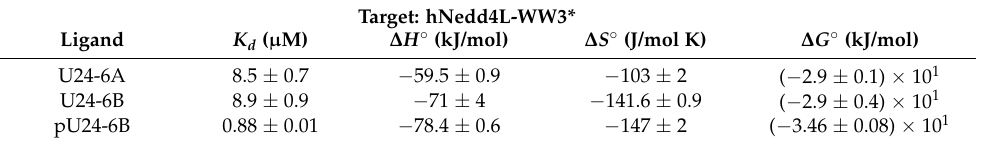
Figure 1. ITC data for ( a ) U24-6A peptide, ( b ) U24-6B peptide, and ( c ) pU24-6B peptide binding to hNedd4L-WW3* at 25 ◦ C. In each case, at least two additional runs were performed and looked nearly identical to the ones shown here. ( a ) (Upper) Raw titration data for nineteen 2 µ L injections of 0.95 mM U24-6A peptide into the ITC cell containing 0.07 mM hNedd4L-WW3* in 10 mM sodium phosphate pH 7.45. ( b ) (Upper) Raw titration data for nineteen 2 µ L injections of 0.51 mM U24-6B peptide into the ITC cell containing 0.034 mM hNedd4L-WW3* in 10 mM sodium phosphate pH 7.45. ( c ) (Upper) Raw titration data for nineteen 2 µ L injections of 1.15 mM pU24-6B peptide into the ITC cell containing 0.068 mM hNedd4L-WW3* in 10 mM sodium phosphate pH 7.45. ( a – c ) (Upper) Insets show heat of dilution data. (Lower) Integrated heat data (points) and best fit (line) to a “one set of sites” model ( n = 1; adjustable parameter). Table 2. Parameters obtained from fitting the ITC data for binding of U24-6A, U24-6B and pU24- 6B to hNedd4L-WW3* domains at 25 ◦ C. Calculated values for ∆ G ◦ are also included. The parameters were obtained from fitting the data from three separate runs and averaging them. The errors represent ± one standard deviation. WW3* domain concentrations used in these experi- ments are in the caption of Figure